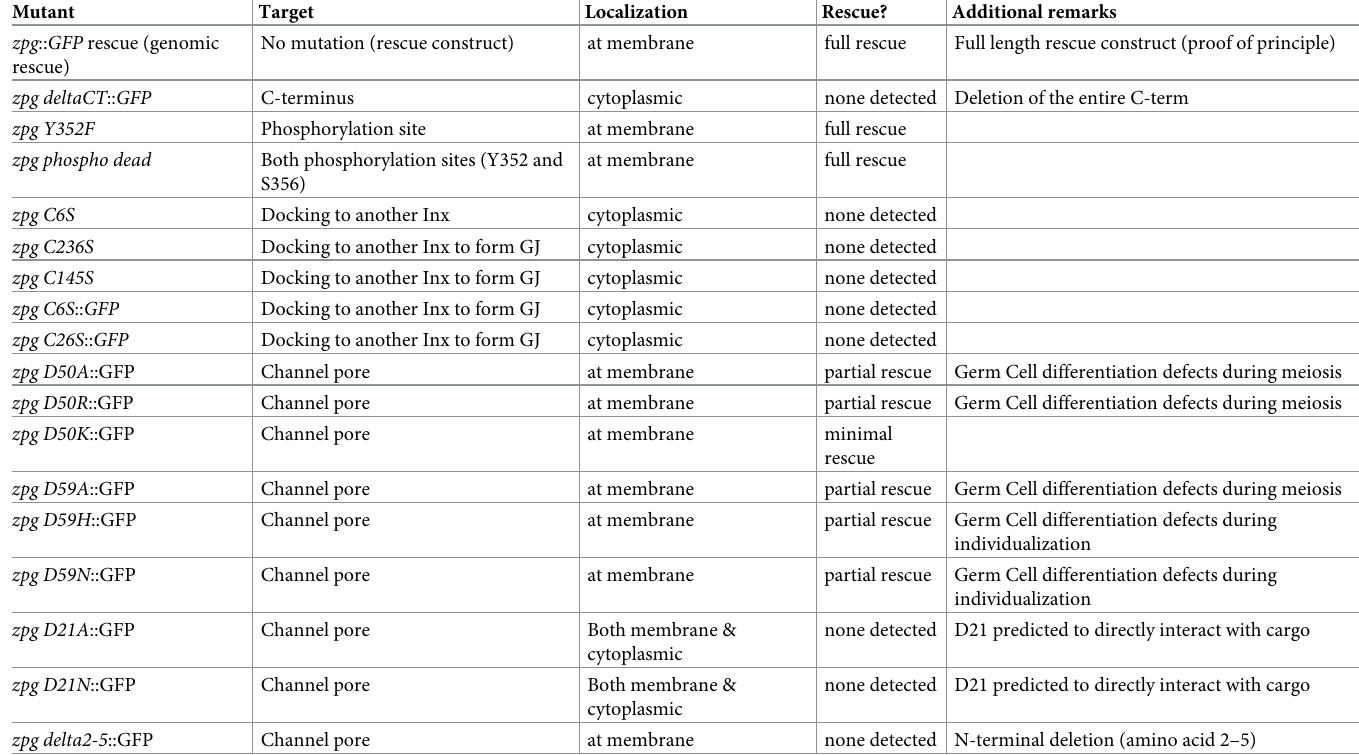
To explore links between specific disruptions of cargo transport through the gap junctions and somatic differentiation, the expression of various somatic markers was studied in channel pore mutants: Mutations in the D50 residue. In testes of zpg D50A and zpg D50R mutants, early somatic cell differentiation was mildly dysregulated, with a higher number of cells positive for the early marker Zfh-1 at the apical tip (Figs 5S, S6L and S6O; means of 84 and 50, n = 10 and 8 for the D50A and D50R mutants, respectively) but normal staining patterns and cell counts for Tj (Figs 5T, S6M and S6P; mean 149 and 152, n = 10 and 12 for D50A and D50R mutants, respectively). The number of cells positive for the late marker Eya however, was significantly Table 1. Summary of the mutants generated in this study. Mutant Target Localization